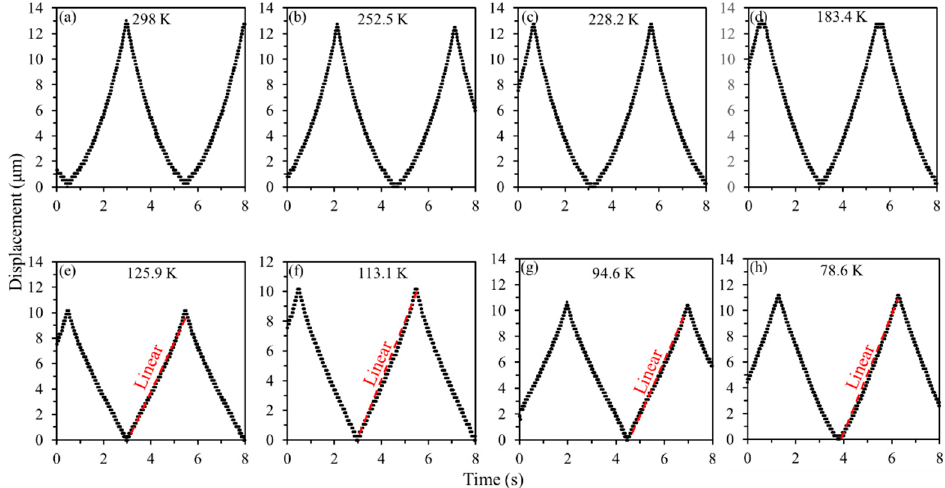
Figure 9. Displacement comparison of the comb-drive actuator with large spring constant at differ- ent temperatures: ( a ) 298 K; ( b ) 252.5 K; ( c ) 228.2 K; ( d ) 183.4 K; ( e ) 125.9 K; ( f ) 113.1 K; ( g ) 94.6 K; ( h ) 78.6 K.